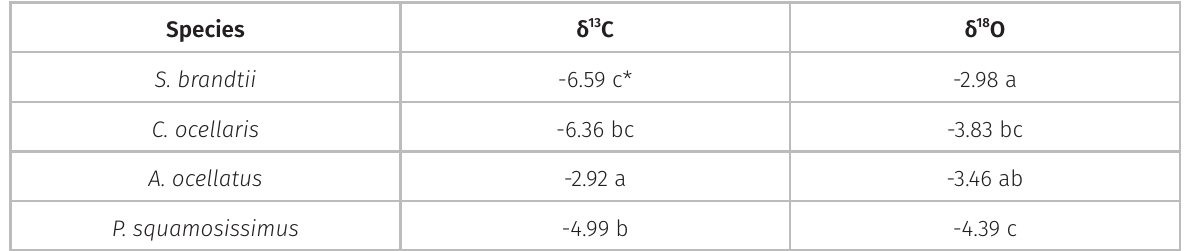
Figure 2. Boxplot of the δ 13 C and δ 18 O values of S. brandtii , P. squamosissimus , C. ocellaris, and A. ocellatus . Table I. Mean values of δ 13 C and δ 18 O for the species S. brandtii , P. squamosissimus , C. ocellaris, and A. ocellatus